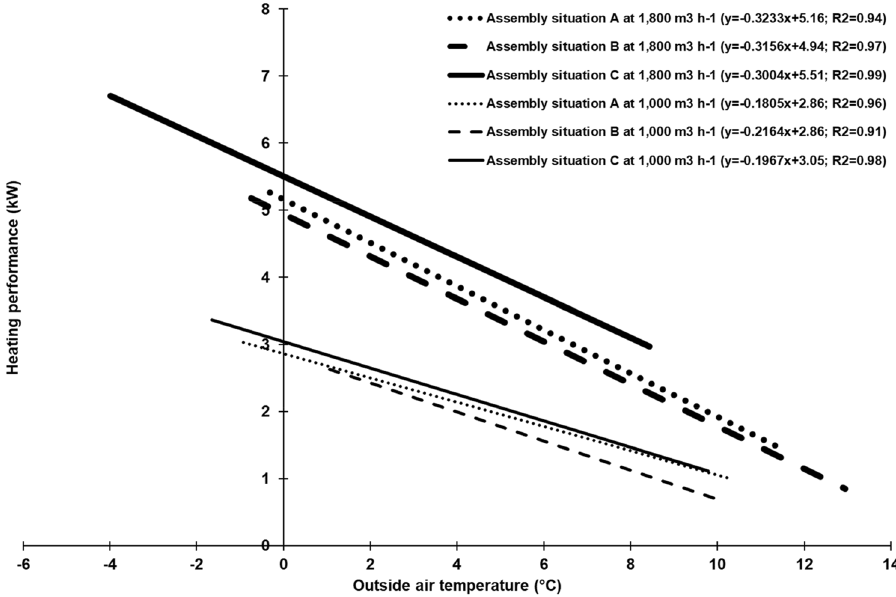
Figure 3. Relationship between heating performance of the exchange scrubber pilot-plant and outside air temperature at different assembly situations of the heat exchanger and different air flow rates (n = 20,400 per each experimental